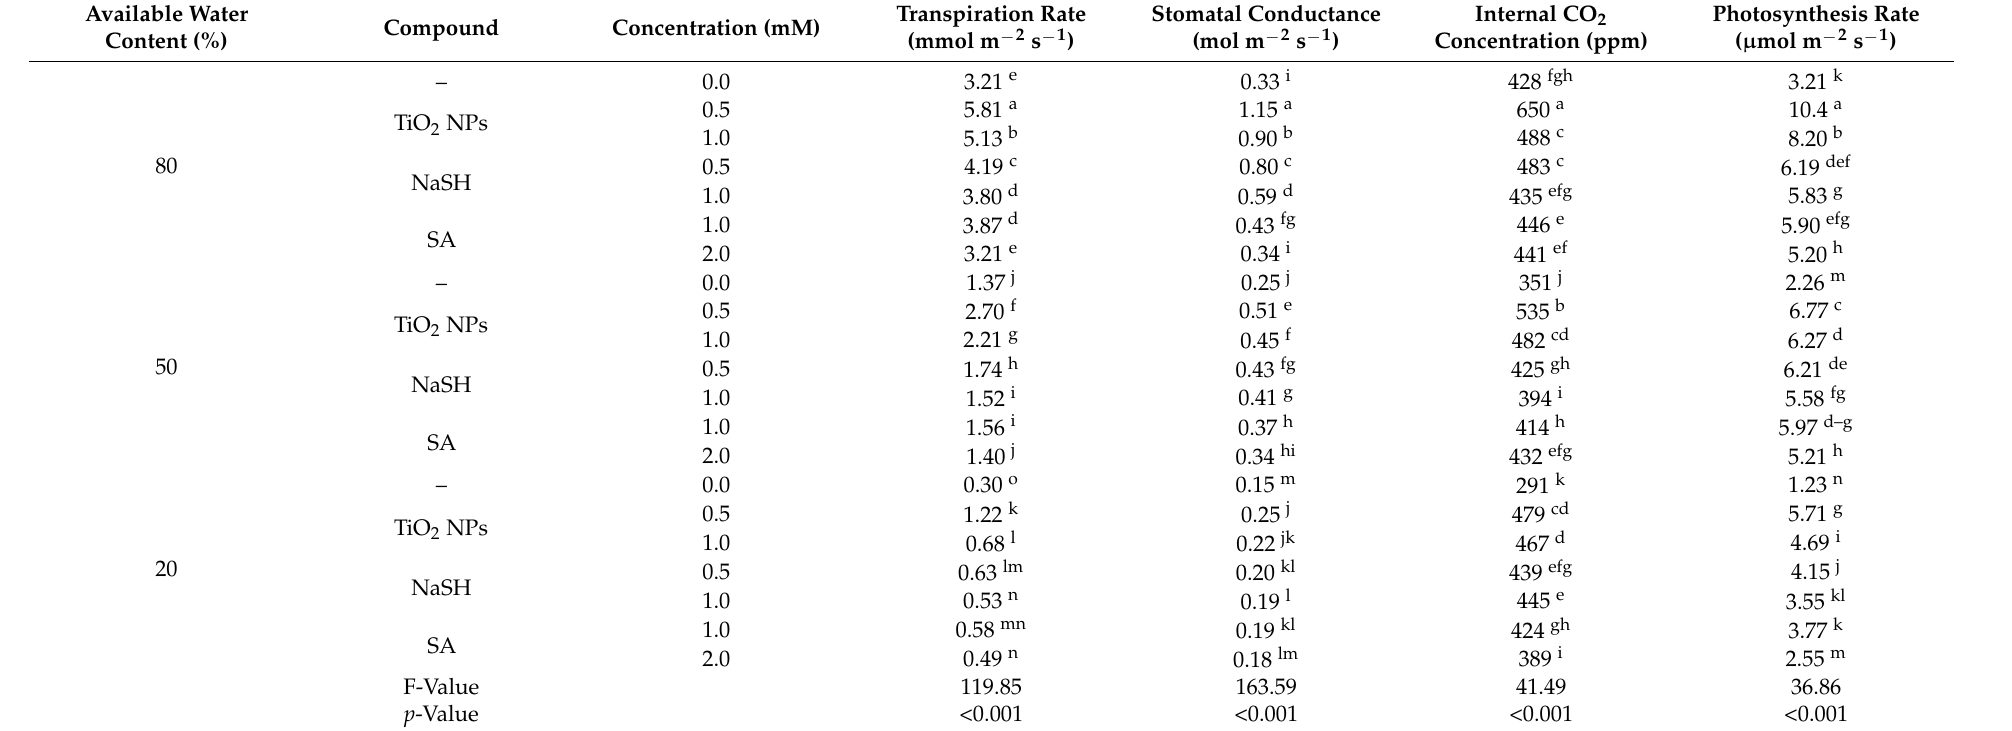
Table 1. Gas exchange features of periwinkle ‘Pacifica XP Really Red’ plants receiving exogenous application of titanium dioxide nanoparticles (TiO 2 NPs; 0, 0.5 and 1 mM), sodium hydrosulfide (NaSH; 0.5 and 1 mM), or salicylic acid (SA; 1 and 2 mM) under different watering levels (80, 50 and 20% available water content) during cultivation. Means followed by different letters indicate significant differences ( p = 0.05; comparison in columns). Values are the mean of four